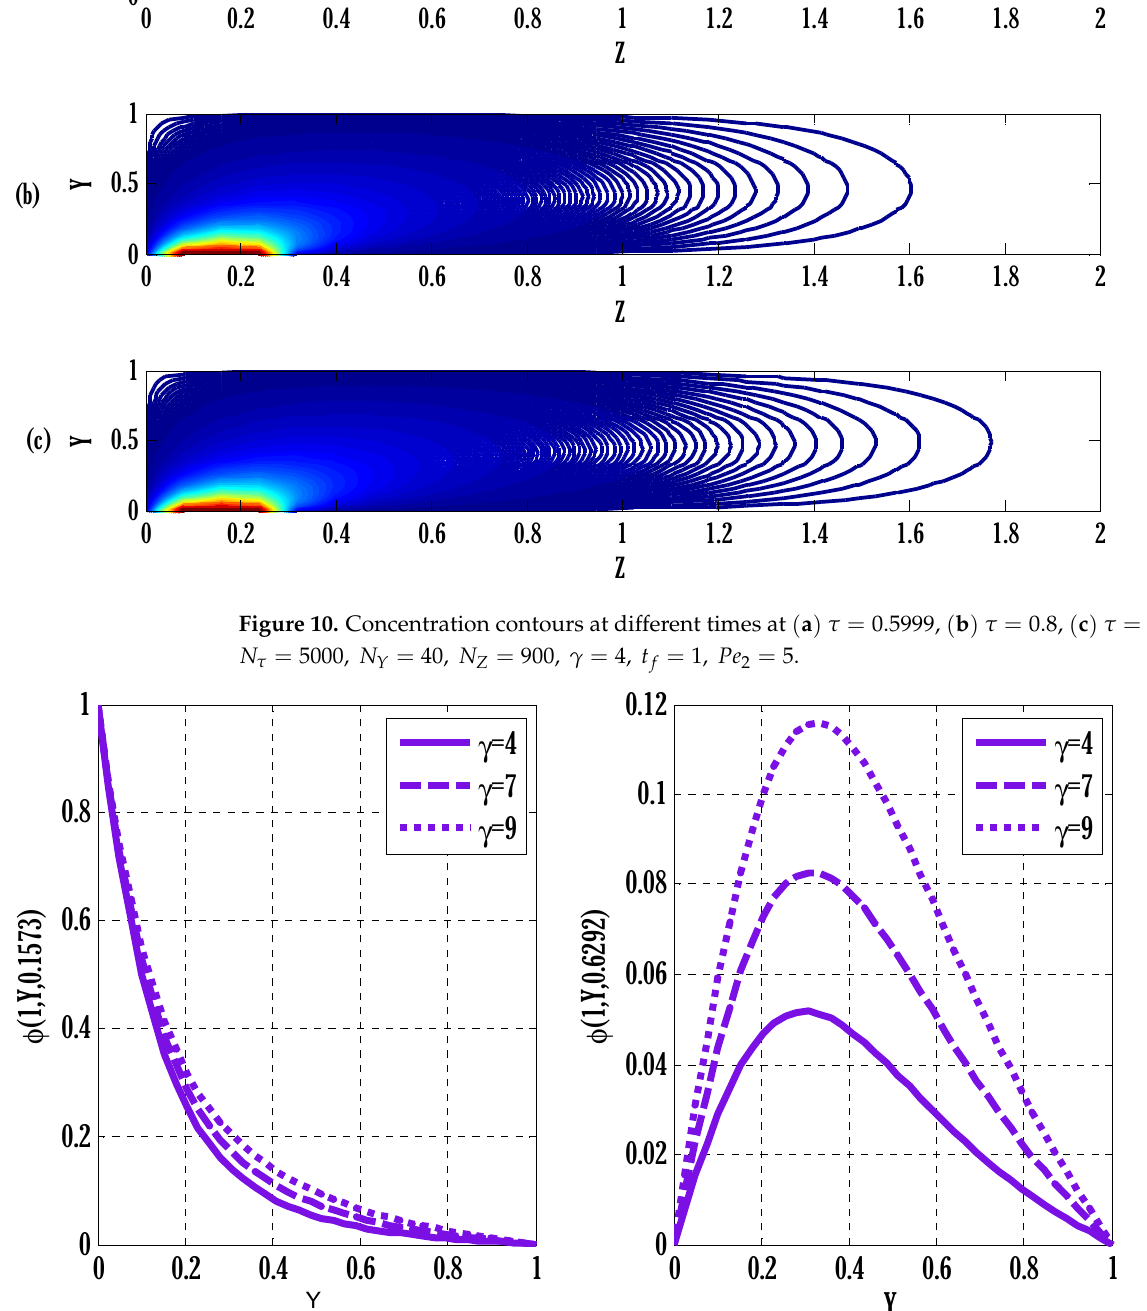
Figure 11. Impact of reaction rate parameter on concentration using N τ = 3000, N Y = 40, N Z = 900, γ = 4, Pe 2 = 10 .